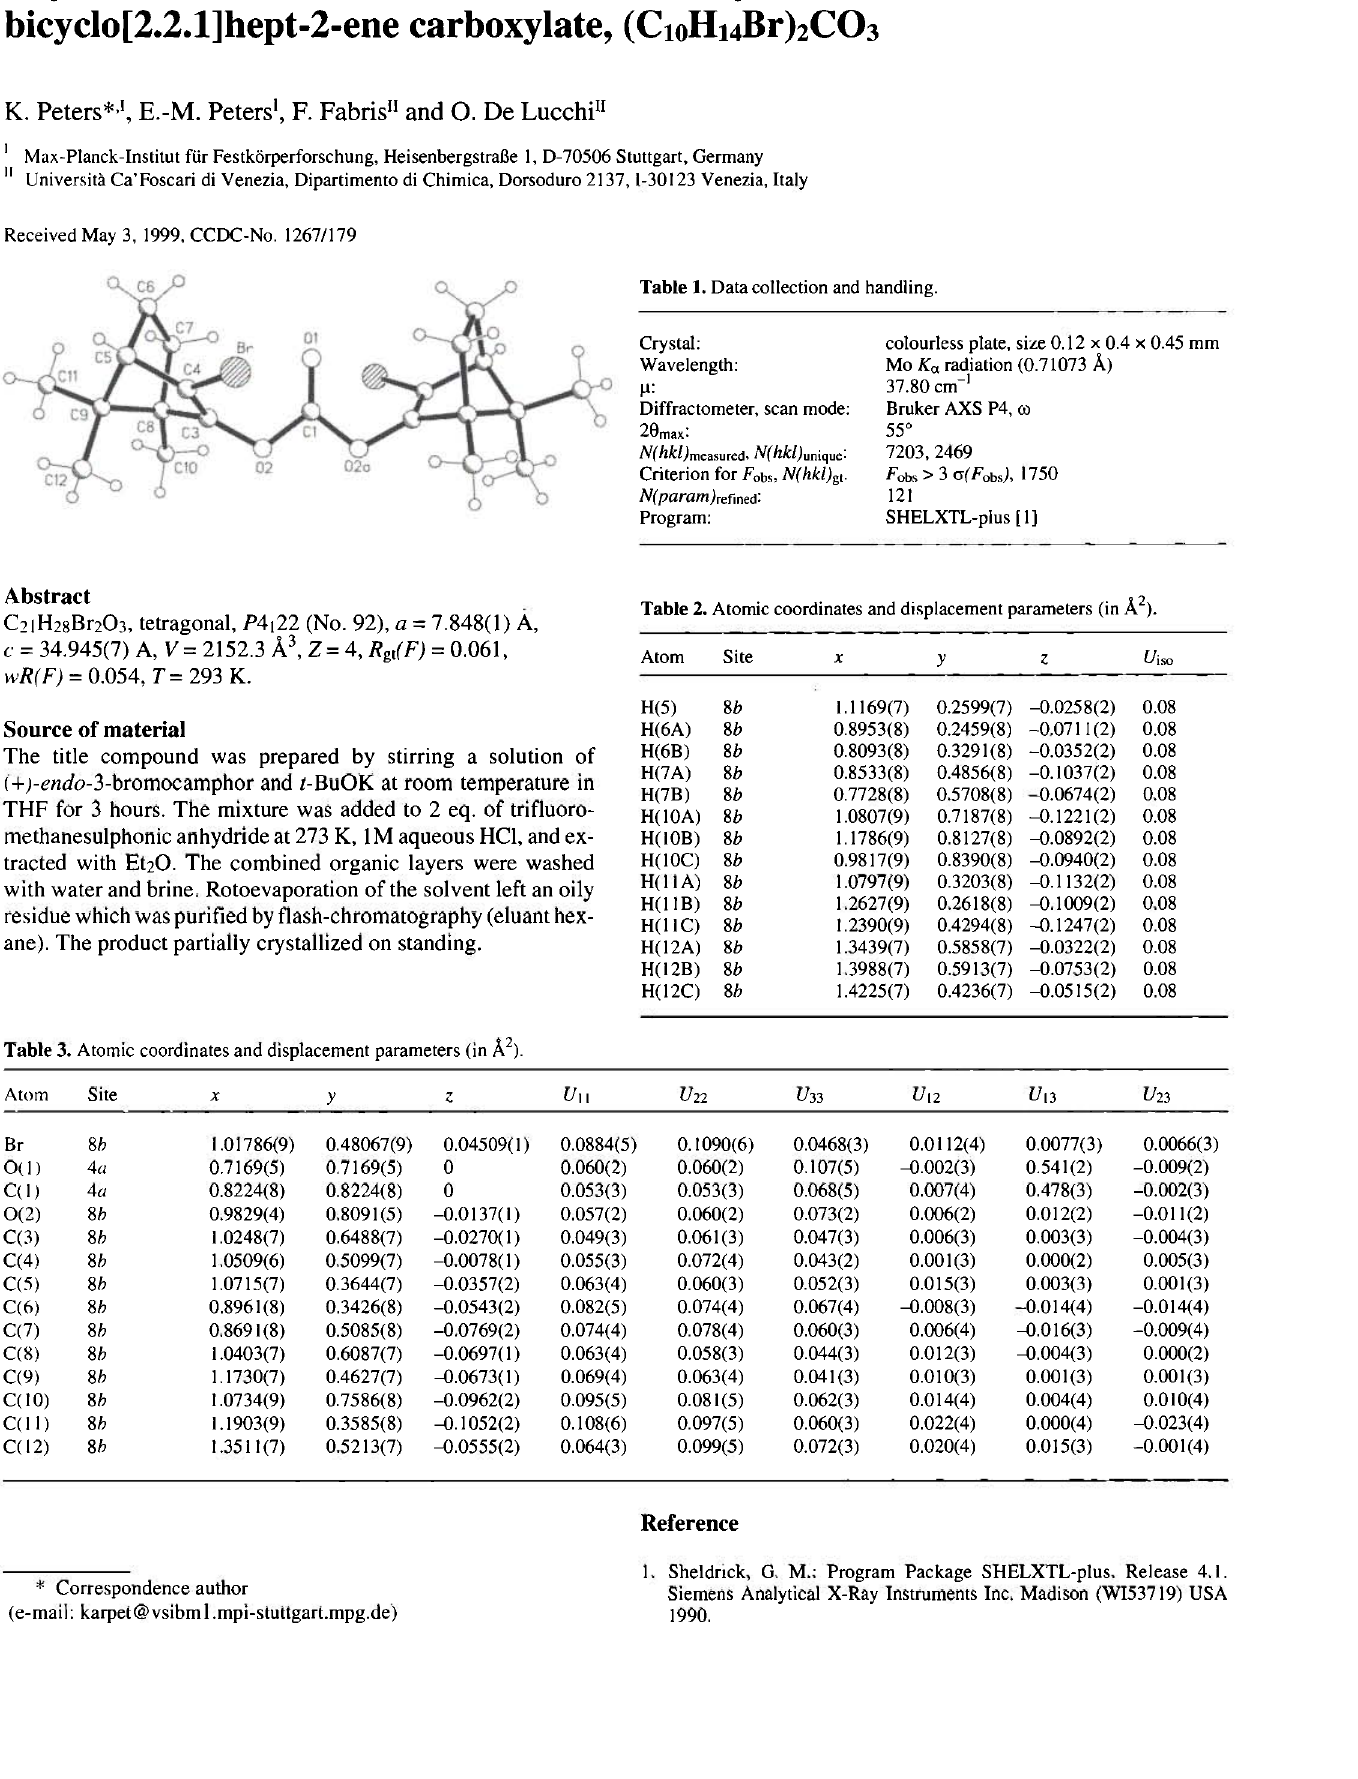
Table 1. Data collection and handling.